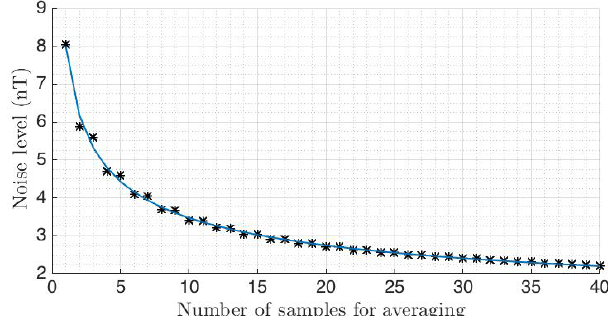
Figure 7. Noise level for different sizes of averaging window. The solid line represents a second-order polynomial fit to the